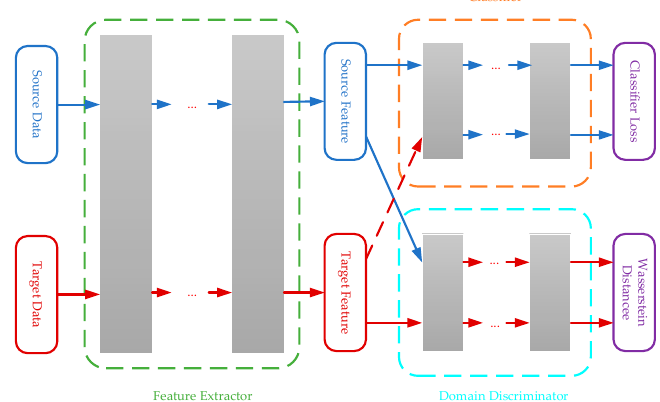
Figure 1. Wasserstein Distance Learned Feature Representations (WDLFR) combined with the